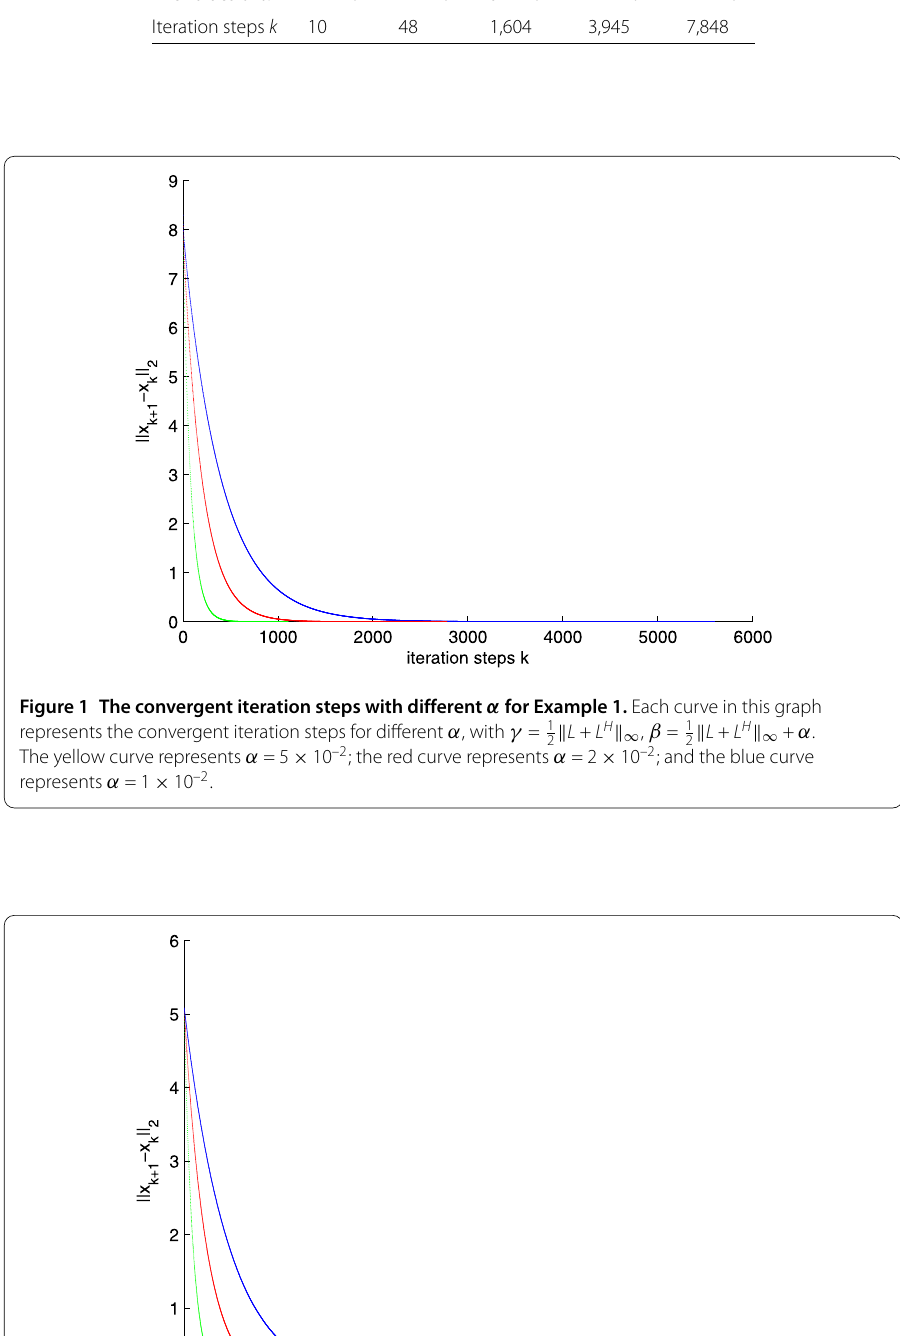
(cid:11) L + L H (cid:11) ∞ , β = 1 (cid:11) L + L H (cid:11) ∞ + α . 2 2